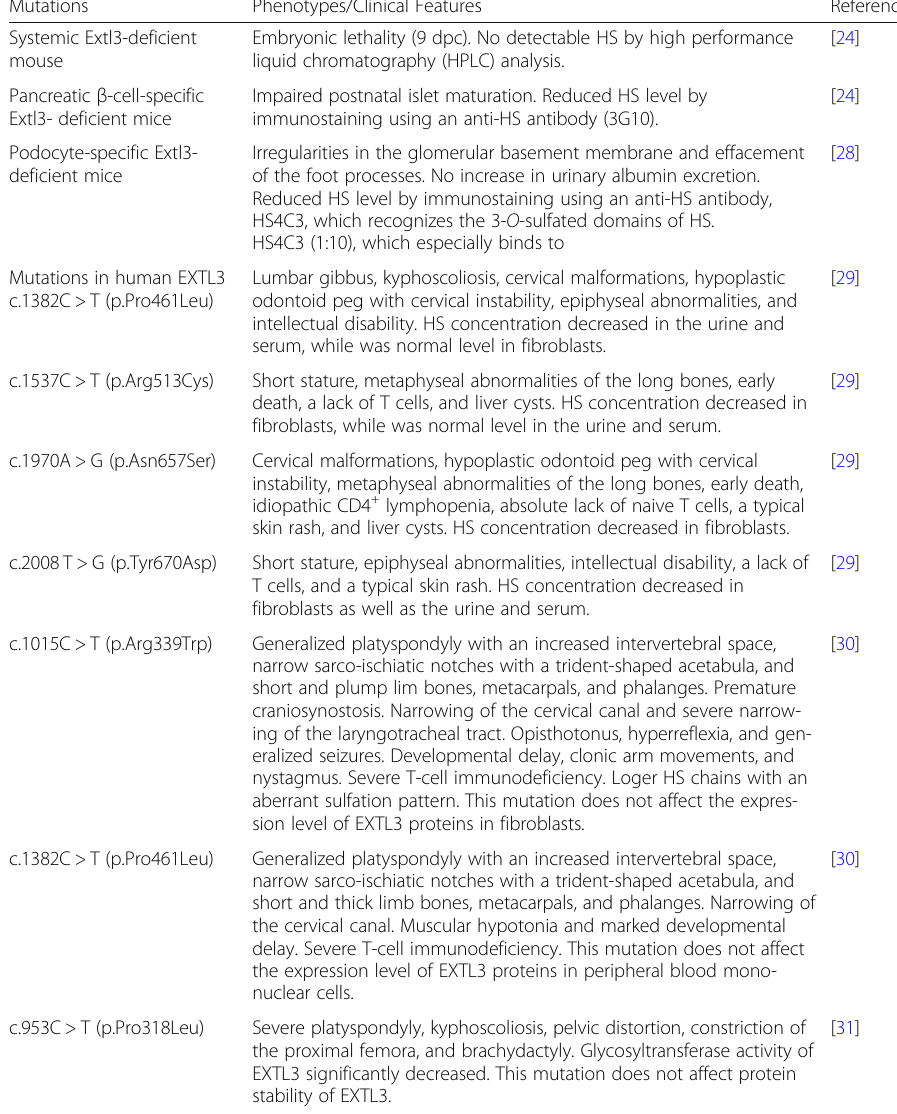
Table 2 Loss of function mutations in EXTL3 gene Mutations Phenotypes/Clinical